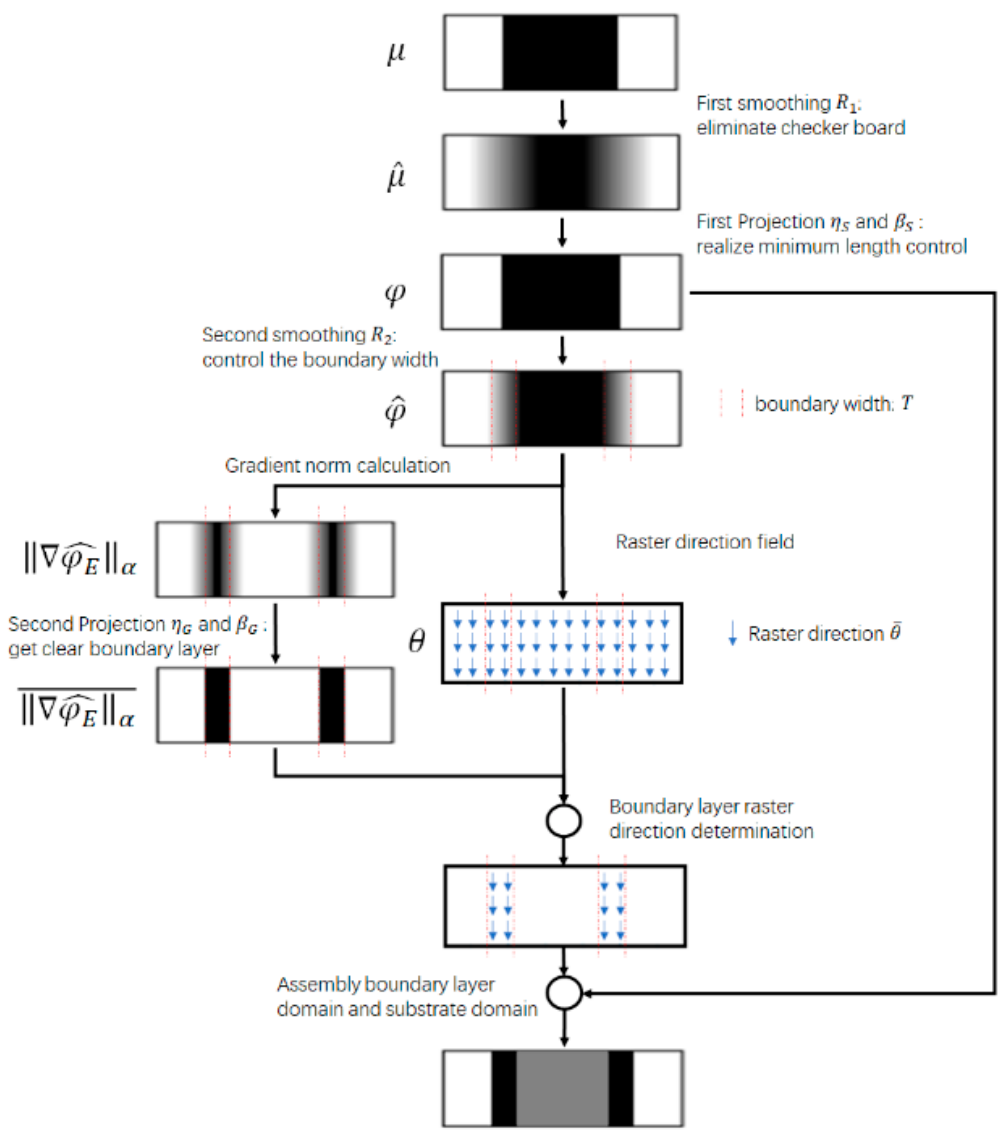
Figure 2. The procedure of the boundary layer deposition direction determination.